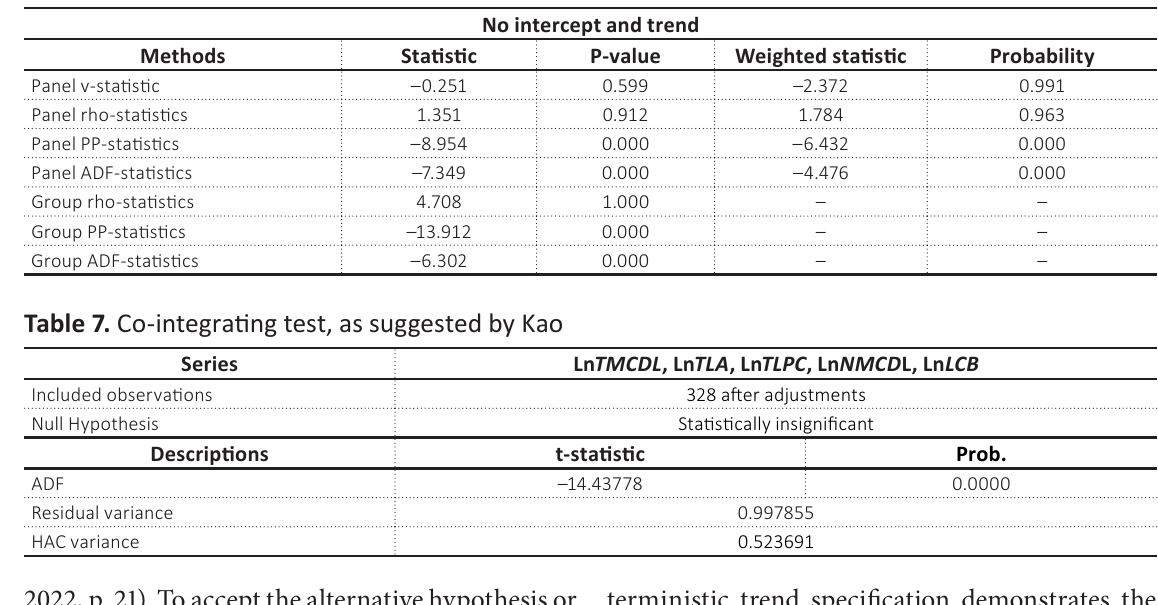
Table 6 (cont.). Products of Pedroni (E-G-based) test